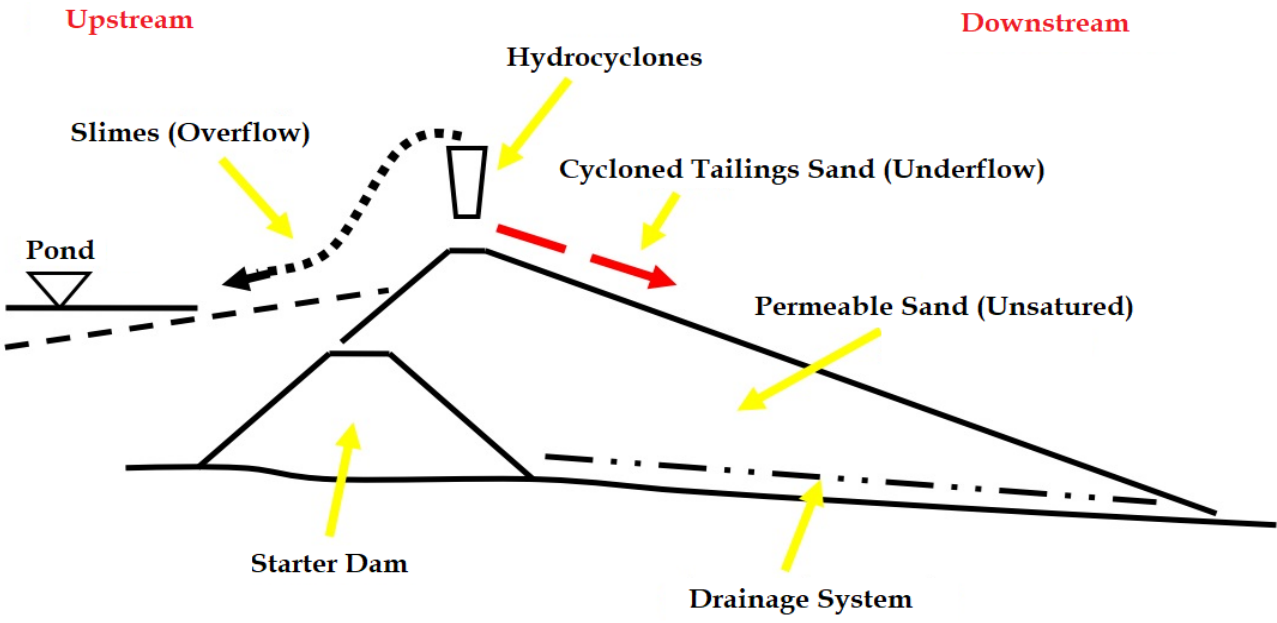
Figure 18. Schematic view of cycloned tailings sand dam construction.